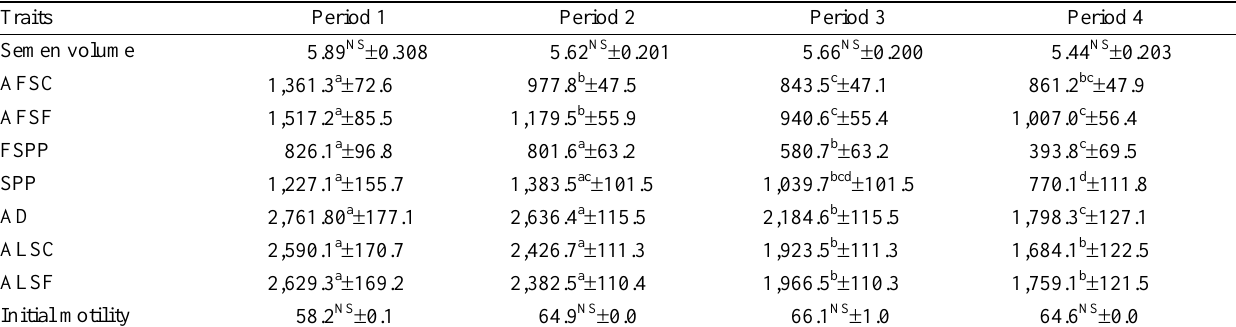
Table 7. Least squares mean  SE for semen volume semen volume, age at disposal, age at first semen collection, age at first semen freezing, frozen semen production period, semen production period, age at last semen collection, age at last semen freezing and initial